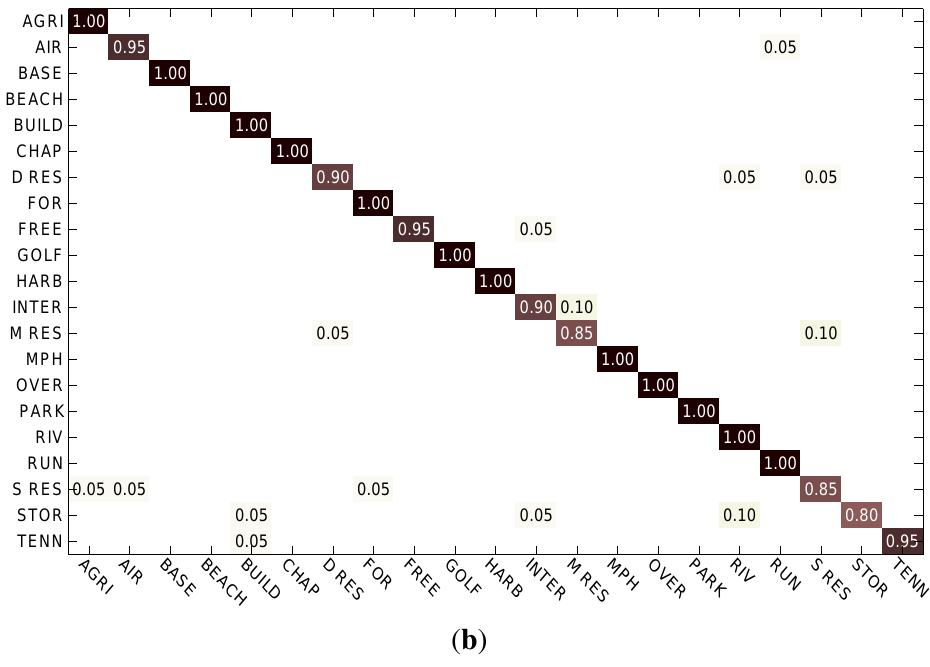
Figure 11. Confusion matrices on the UCM dataset using IFK with SIFT features and dense CNN features. ( a ) Confusion matrix of IFK with SIFT features; ( b ) Confusion matrix of IFK with dense CNN features.